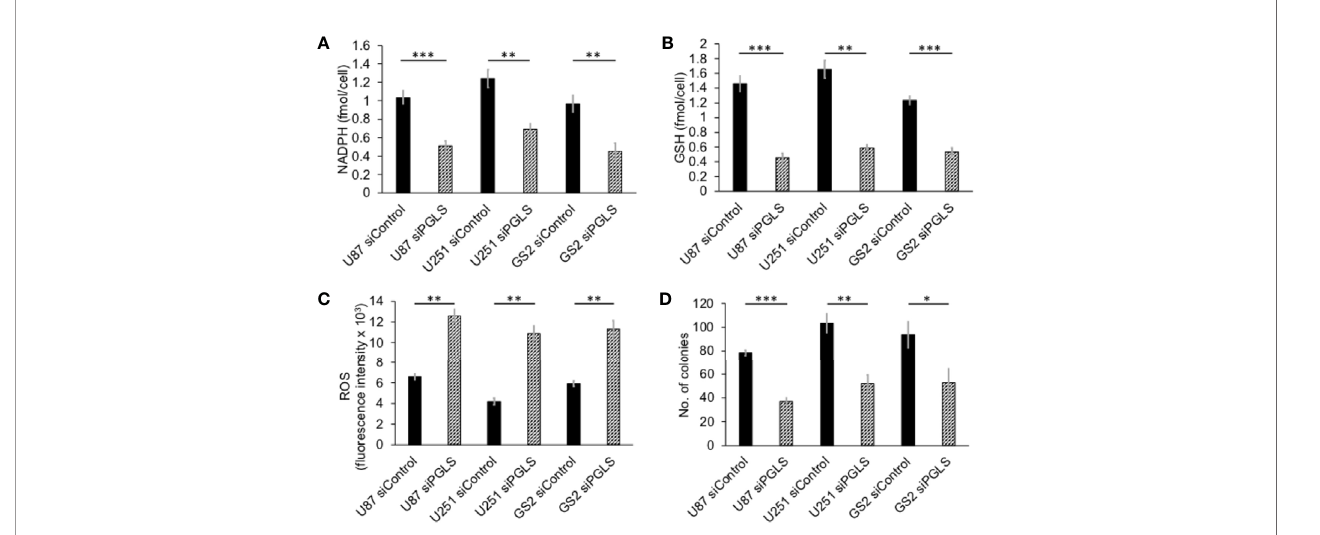
FIGURE 2 | PGLS is linked to redox in glioblastoma cells. Effect of PGLS silencing by RNA interference on NADPH (A) , GSH (B) , ROS (C) and clonogenicity (D) in the U87, U251 and GS2 glioblastoma models (n = 3). * indicates p < 0.05, ** indicates p < 0.01, *** indicates p <